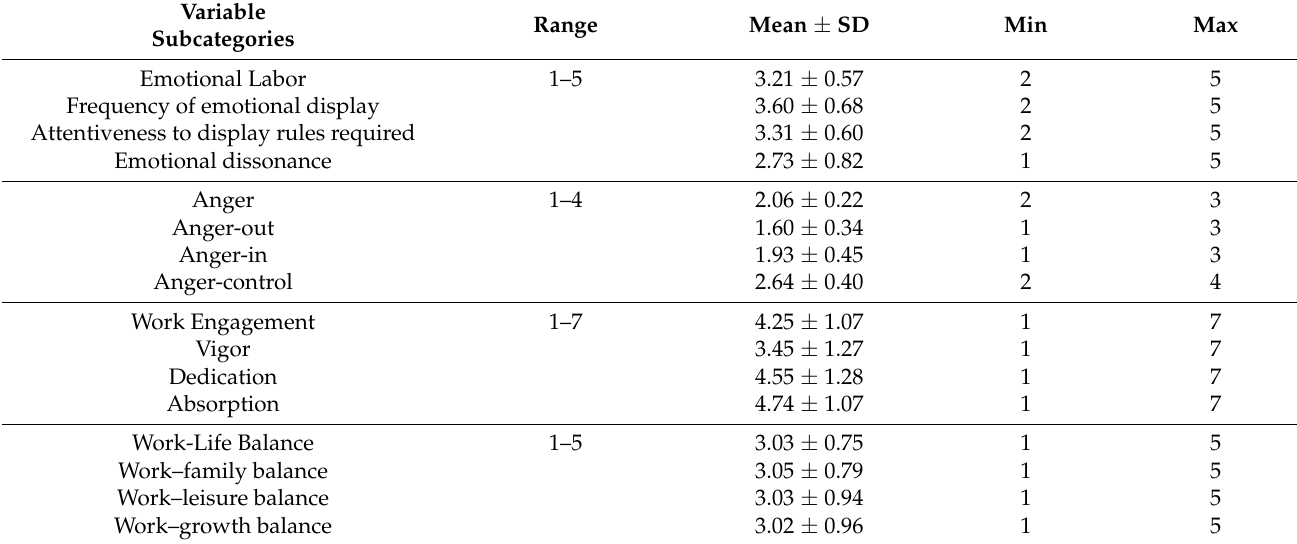
Table 2. Scores for Emotional Labor, Anger, Work Engagement, and Work-Life Balance.